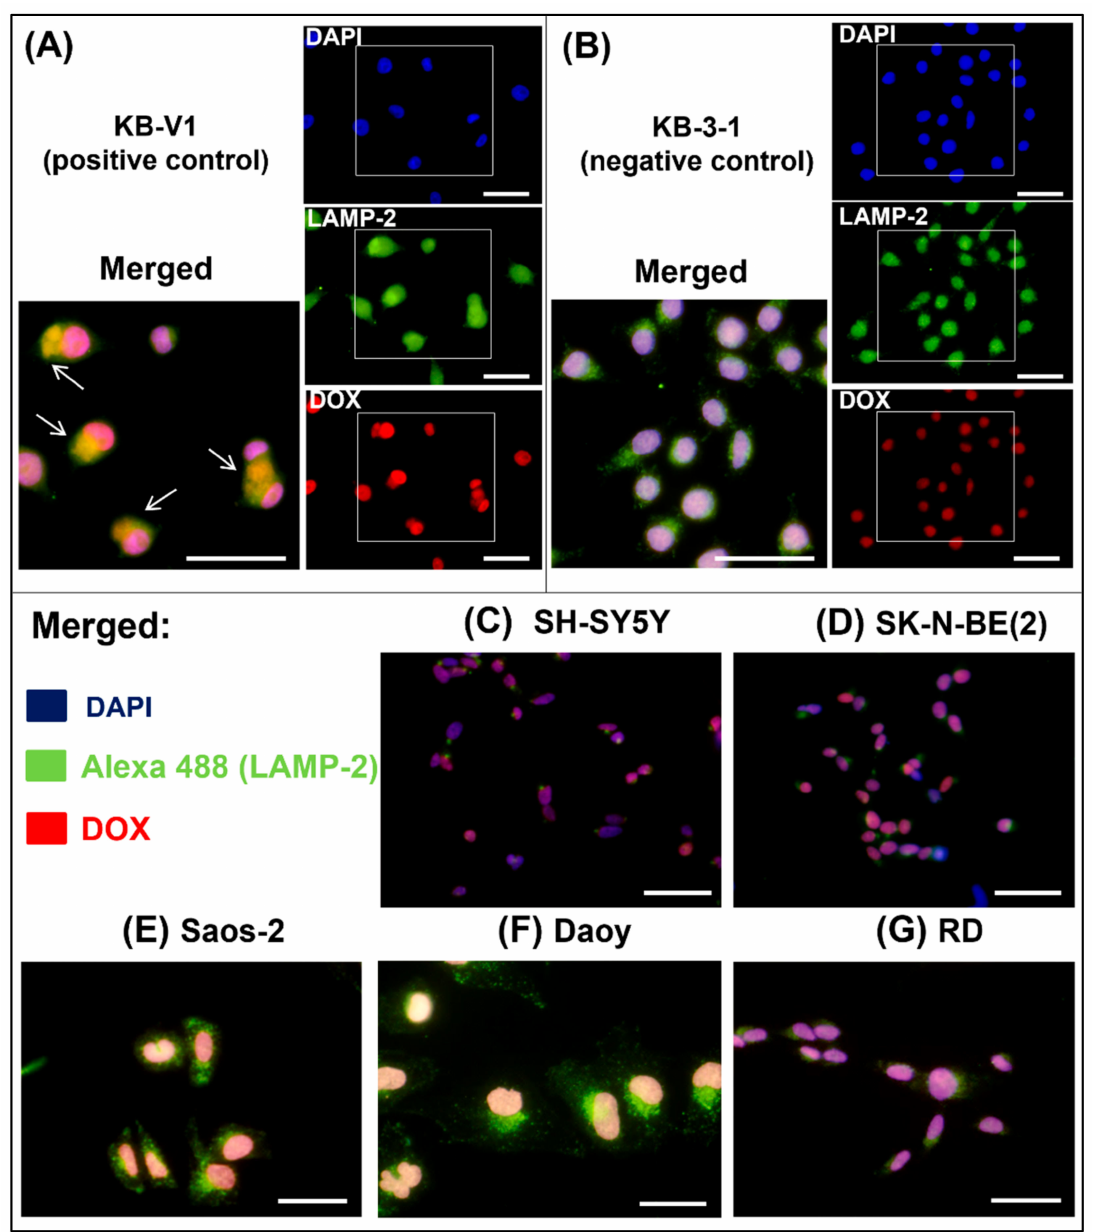
Figure 4. DOX localization in cells. All cell lines were treated with 10 µ M doxorubicin (DOX). The localization of DOX (red fluorescence) within cells after 2 h of treatment was observed using fluorescence microscopy. Additionally, the target organelles, lysosomes, and nuclei were stained. The lysosomes were visualized by indirect immunofluorescence using an anti-LAMP-2 primary antibody and an Alexa-488-conjugated secondary antibody (green fluorescence). The nuclei were labeled with DAPI (blue fluorescence). The KB-V1 cell line ( A ) served as a positive control for the lysosomal sequestration of DOX (indicated by arrows: yellow fluorescence—overlap of green and red fluorescence emissions). In contrast, the KB-3-1 cells served as a negative control ( B ). The analyses were performed with all five selected cell lines: SH-SY5Y ( C ), SK-N-BE(2) ( D ), Saos-2 ( E ), Daoy ( F ), and RD ( G ) cells. The scale bars represent 50 µ